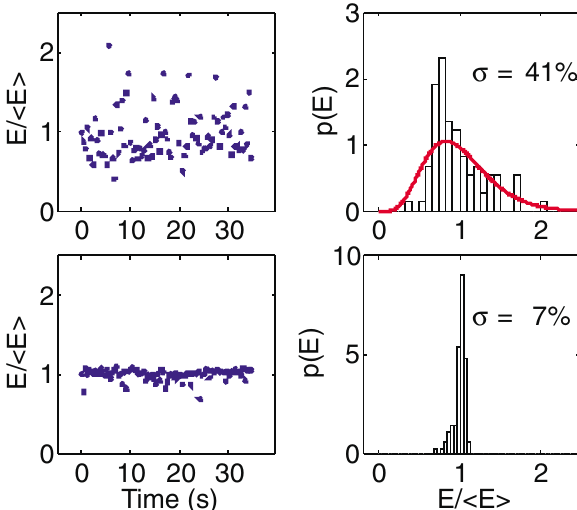
FIG. 8. TDA simulation showing the energy of the HGHG as a function of radiator distance for various seed laser and dis- persion magnet currents. For the gray curves the maximum bunching occurs within the first two gain lengths of the radiator, whereas the black curves are simulated using the experimental parameters of each seed power case. The gray curves oversaturate and thus the output power is reduced. For this reason the dispersion is optimized for the maximum output at the end of the